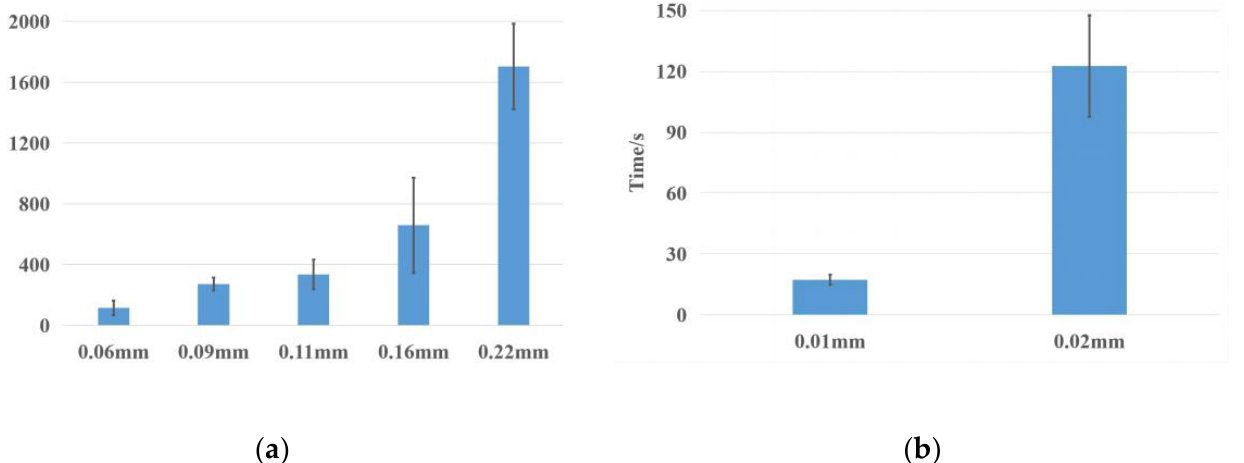
Figure 6. ( a ) Dissolution time of PVA1 membranes with different thickness, where the membrane marked 0.22 mm is a superposition of two 0.11 mm membranes. ( b ) Dissolution time of PVA2 membranes with different thickness.